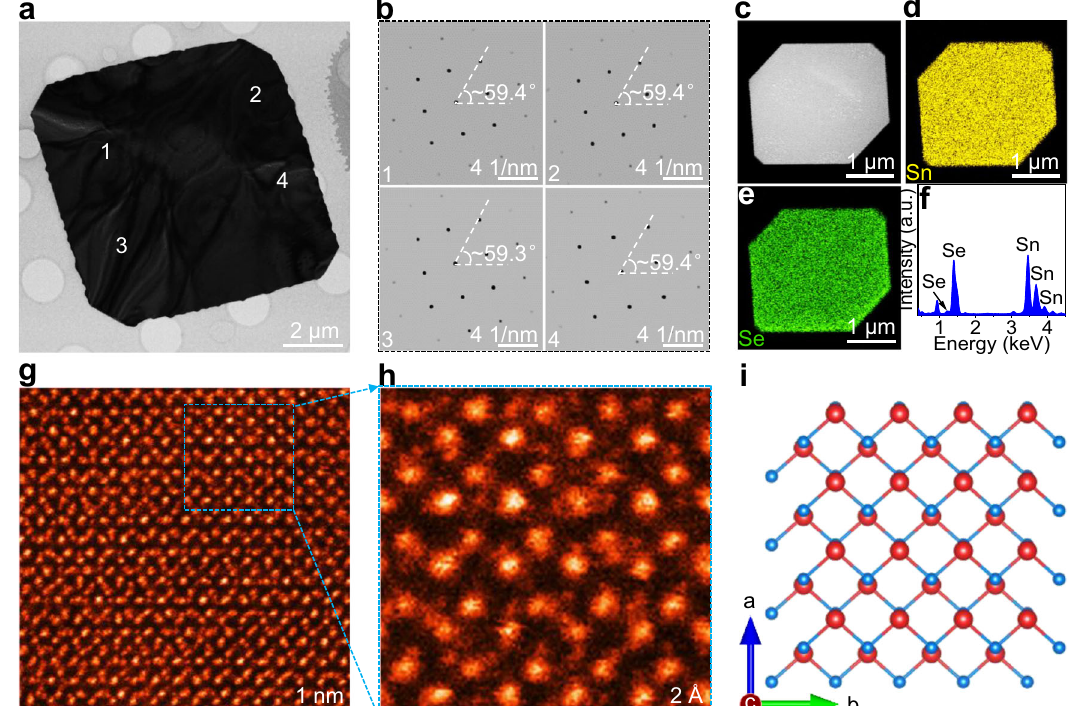
Fig. 2 | Atomic structure ofPVD-synthesized 2D SnSe. a Low-magni fi cation TEM image of a typical tetragonal SnSe nanosheet. b Corresponding SAED patterns captured from the random positions labeled with numbers 1 − 4 in a . c Low- magni fi cation TEM image of a tetragonal SnSe nanosheet. d , e Corresponding EDS